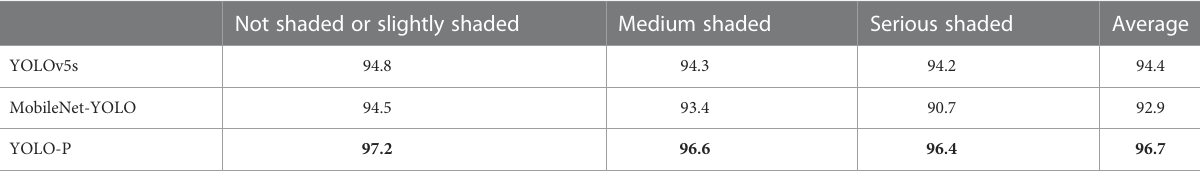
TABLE 7 F1 score (%) in different shaded degrees experiments during daytime. Not shaded or slightly shaded Medium shaded Serious shaded Average 94.8